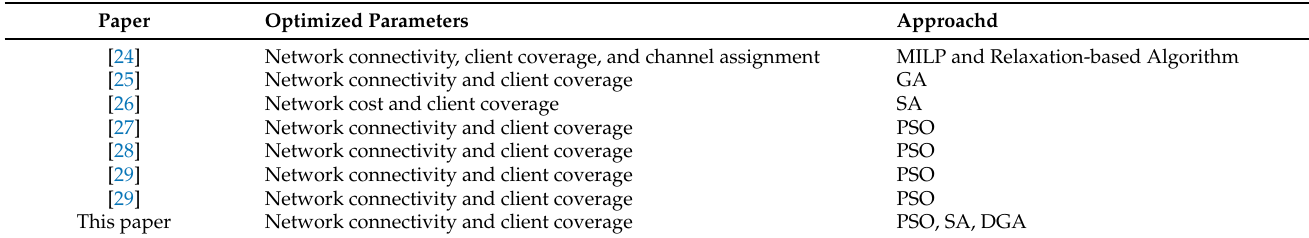
Table 1. Summary of research works with regards to the problem solved and the approach